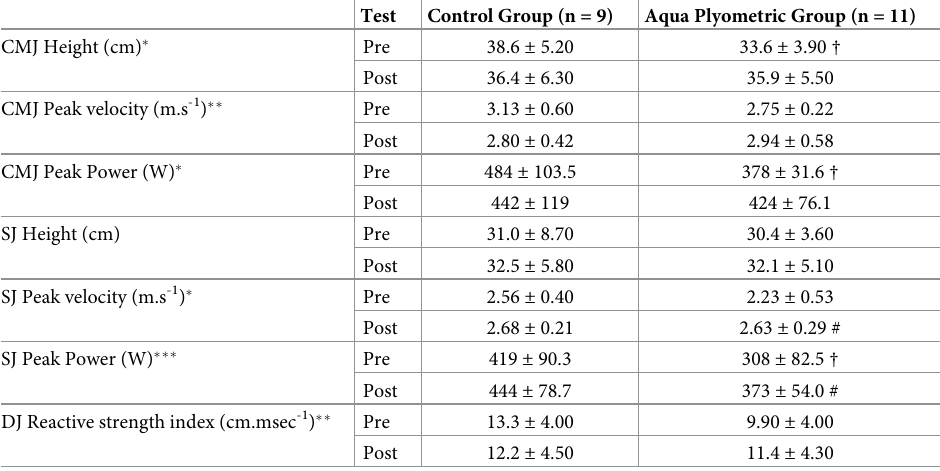
Table 2. Mean ± standard deviation for counter movement jump, squat jump and drop jump